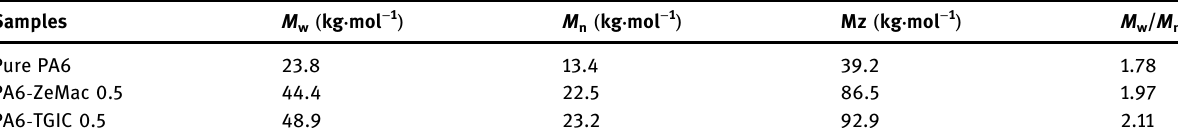
Table 3: Molecular properties of the pure PA6, PA6 - ZeMac, and PA6 - TGIC 0.5 Samples